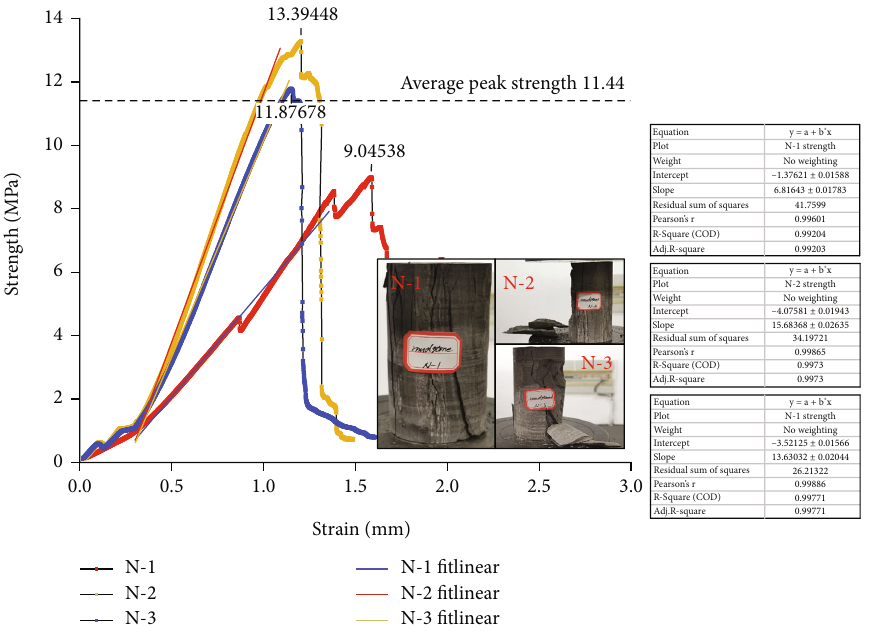
Figure 2: Failure modes and stress-strain curves of mudstone under the dry